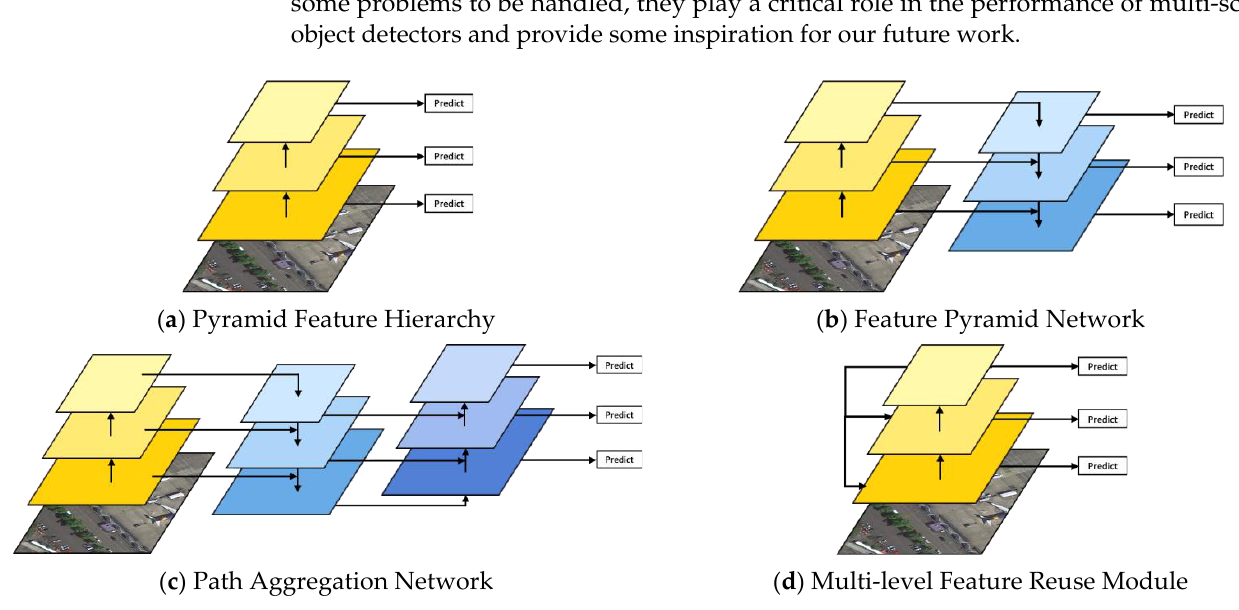
Figure 2. Different feature pyramid network structures. ( a ) Predict using feature maps of different sizes; ( b ) combining information from top and bottom feature maps; ( c ) adding top-down and bottom-up paths; ( d ) multi-level feature reuse pyramid. Table 1. The advantages and disadvantages of different object detection